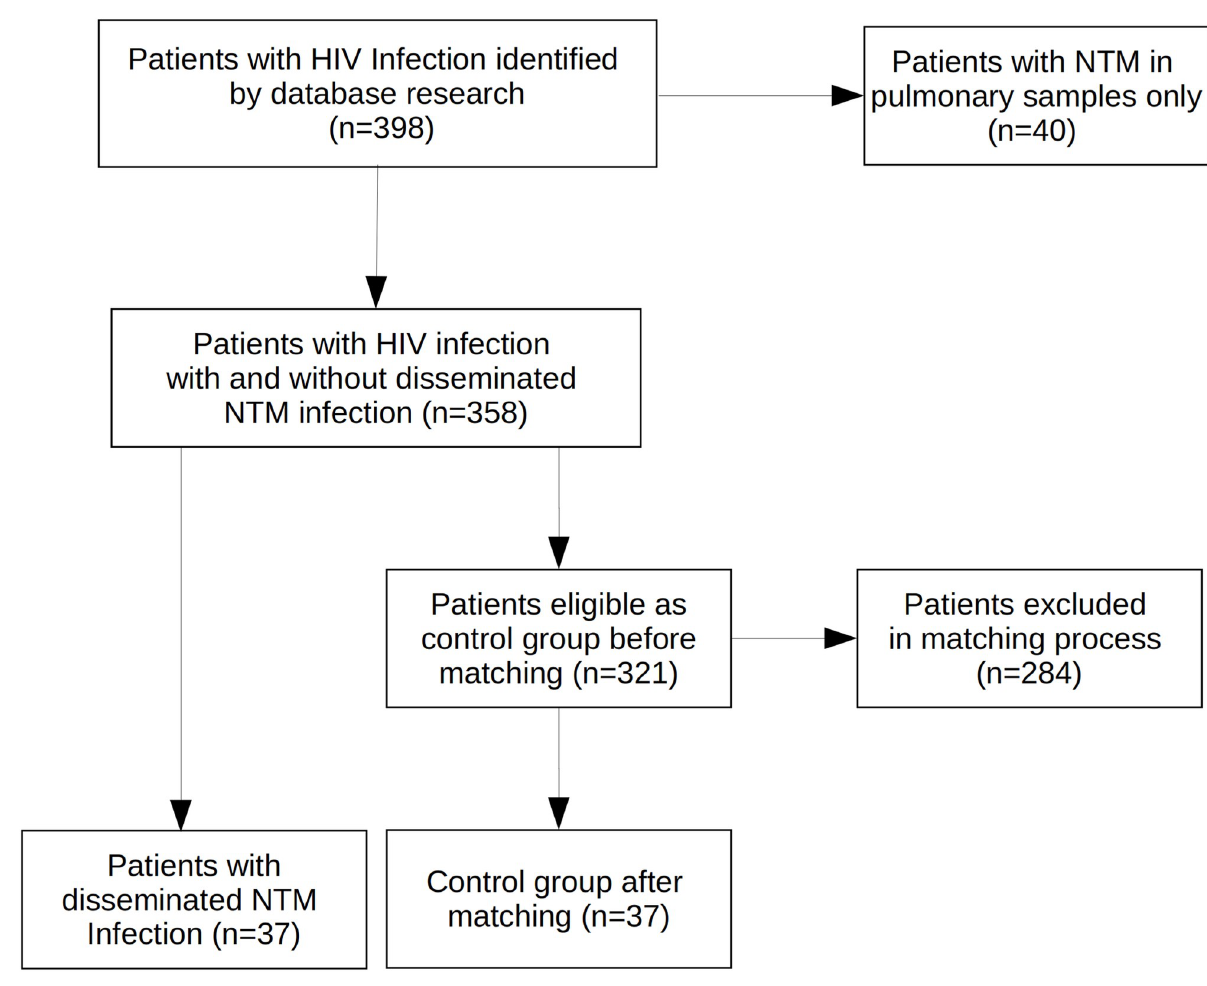
Fig 1. Flowchart of patient inclusion and exclusion. https://doi.org/10.1371/journal.pone.0254607.g001 284 patients, delivering a control group of 37 patients, as well ( controls ). Median CD4 cell count at first diagnosis was 5/ μ l (IQR = 22/ μ l) in patients with disseminated NTM disease, 198/ μ l (IQR = 273/ μ l) in controls before matching and 11/ μ l (IQR = 26/ μ l) in controls after matching (Fig 2). There was no significant difference in CD4 cell count between the case and the control group after the matching process (p = 0.33).